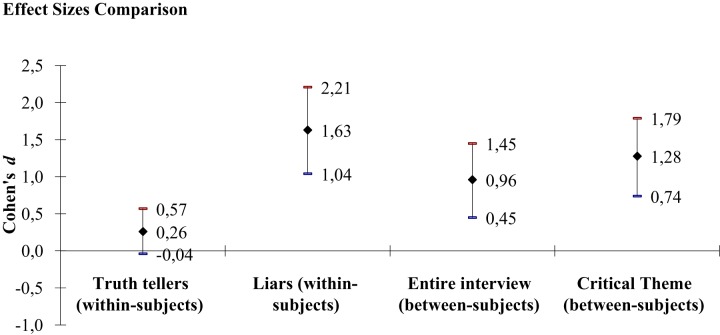
Comparison of between-subjects and within-subjects effect sizes, with 95% confidence intervals. Cohen’s d was computed with original metrics without controlling for the covariates.